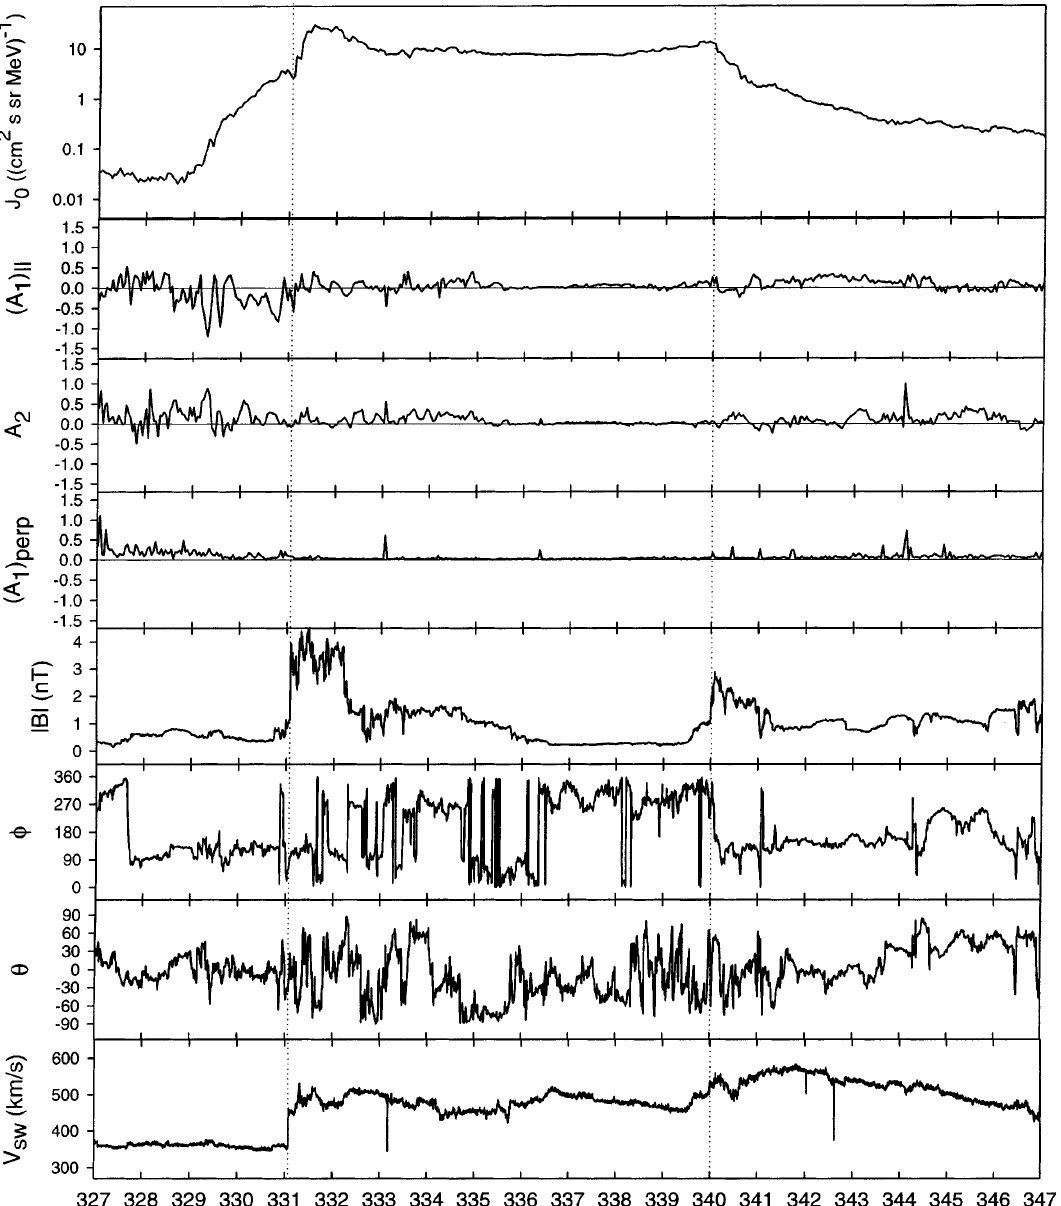
Fig. 1. Overview of the November 1998 event. The omnidirectional flux J , component of the first order anisotropy along the magnetic 0 field, second order anisotropy A